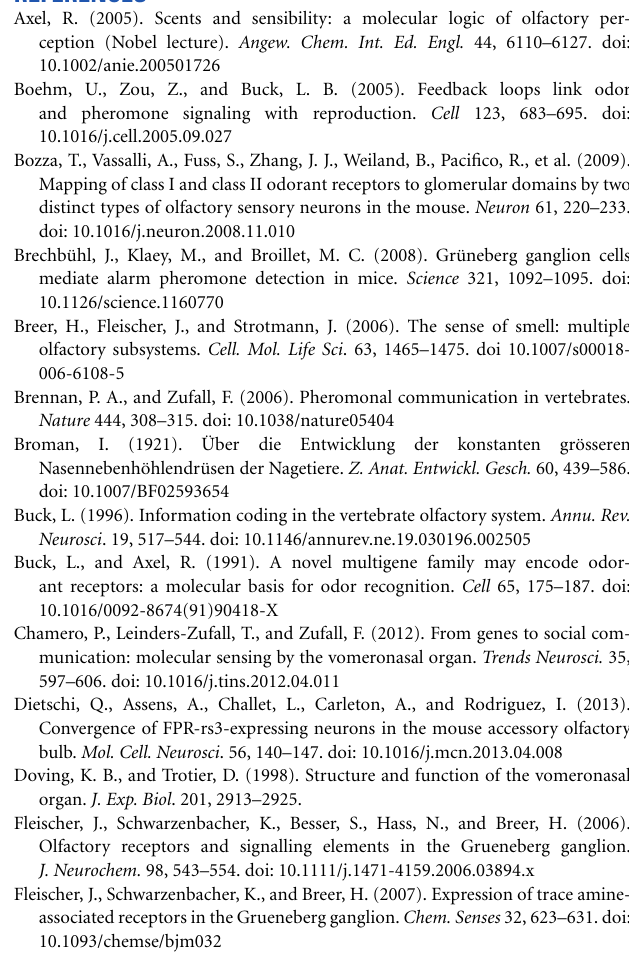
Yellow indicates MOE with 3-5 rows of cells, green 6-10 rows, and blue 11 or more rows (see also Figure 2